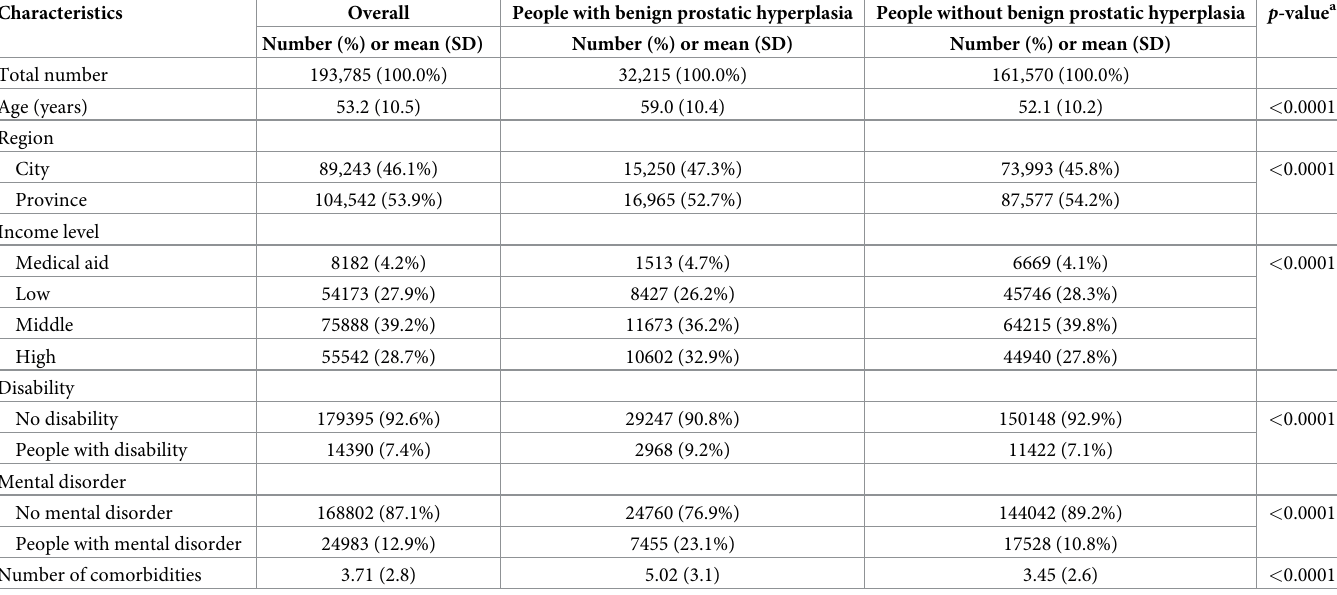
Table 1. Baseline characteristics of patients diagnosed with benign prostatic hyperplasia and general population without benign prostatic hyperplasia. Characteristics